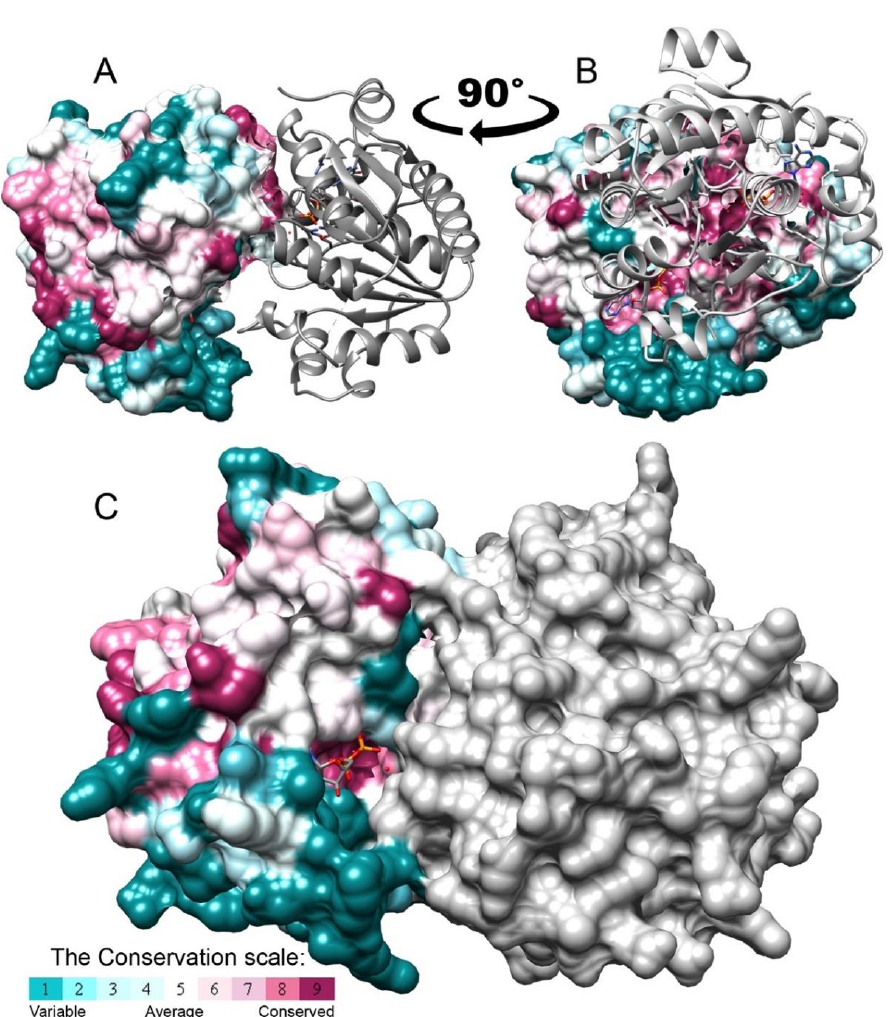
Figure 6. The isolated BceF kinase domain forms a dimer in the crystal structure. A dimer of the BceF kinase domain was observed in the crystal structure, demonstrating a partial obstruction of the active site. One monomer is colored grey and the other by evolutionary conservation scores calculated using the ConSurf web server [21–23]; a variable-to-conserved colored scale is indicated. ADP, present in the crystal structure, is shown in format of sticks and colored by atom type. ( A , B ) Two views (representing −90° rotation along the vertical direction) of the BceF dimer with one monomer displayed as ribbons and the other as solvent-accessible surface representation. ( C ) The two monomers are showed using a solvent-accessible surface representation.